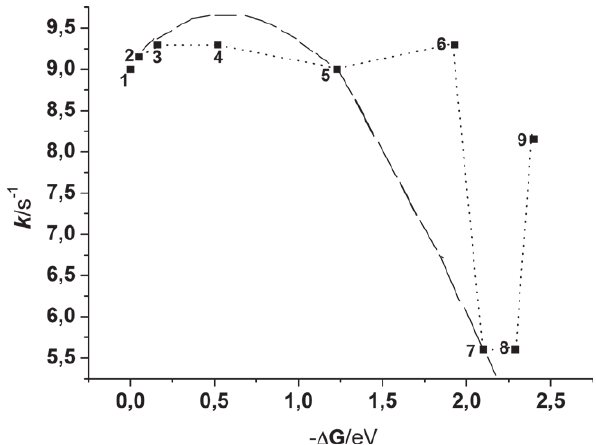
Figure 1. System biphenylyl–spacer–acceptor in isooctane solu- tions. Dashed line correspond to calculations [14] with the follow- ing parameters: λ s = 0.15 eV, λ v = 0.45 eV, ω = 1500 cm -1 , V = 6.2 cm -1 . Dotted line is just a guide for eye that is drown according to the sequence of the reaction free energies. The symbols indicate experimental data: 1 — 4-biphenylyl, 2 — 2-naphthyl, 3 —